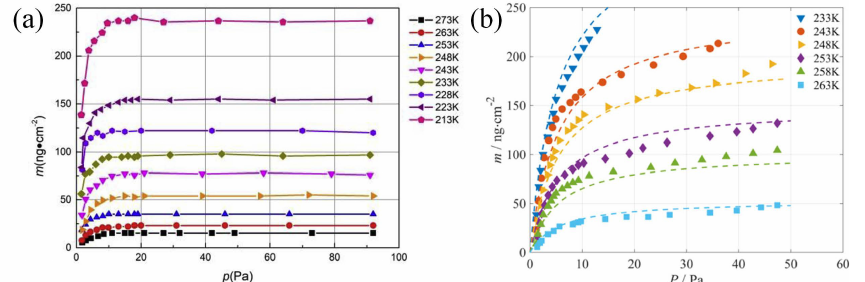
Figure 22. Saturation gas adsorption at the conditions of low-temperature and low pressure for ( a ) CO 2 [83] and ( b ) H 2 O [84].